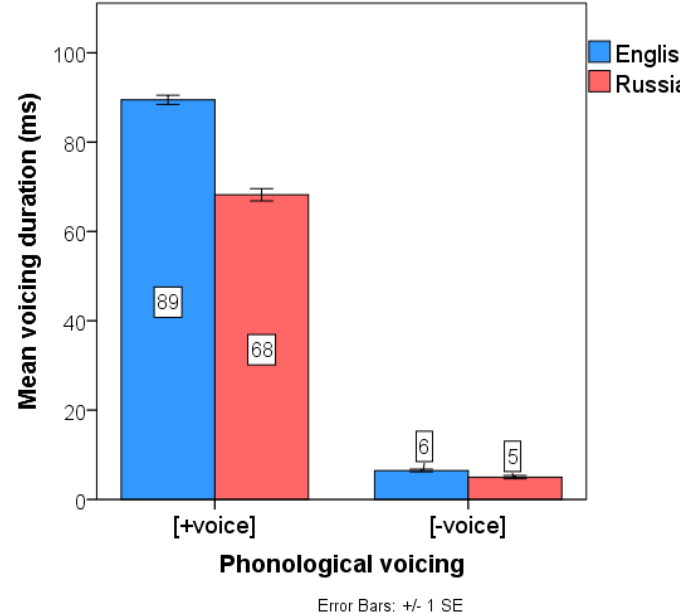
Figure 13. Mean duration of laryngeal voicing during closure or frication portion of the final voiced and voiceless obstruents in learners’ English and Russian.